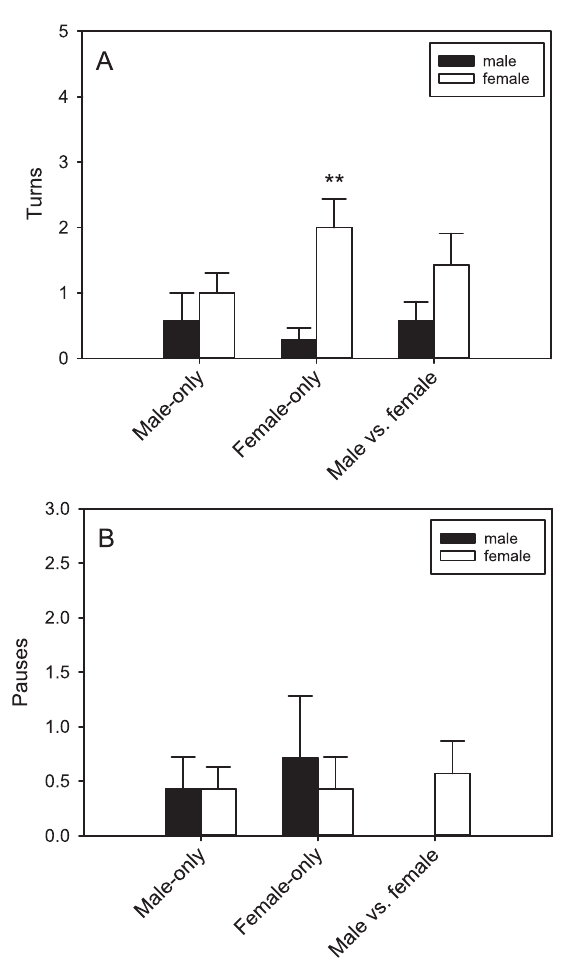
Fig 7. Turning behavior during scent trailing. A) Turning behavior was female-biased in tegus during the initial phase of trials, B) but pausing behavior was not. Bars represent means (+SEM). �� P < 0.01.